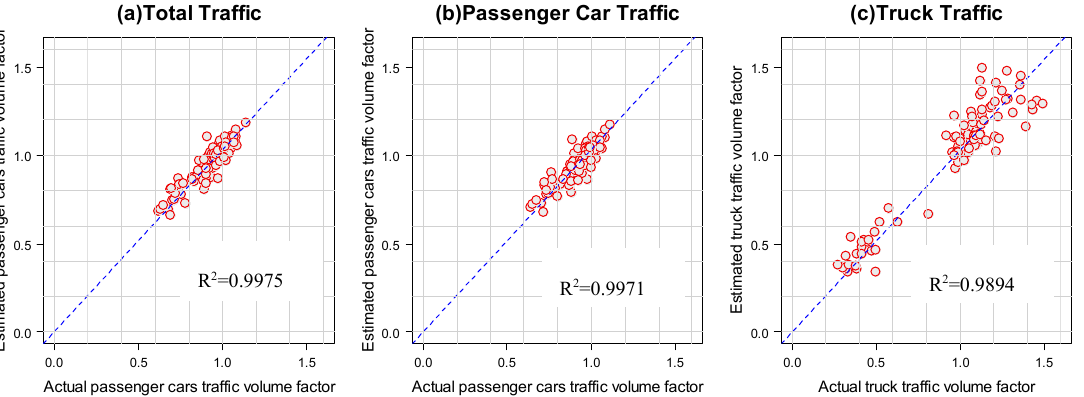
Figure 12. The accuracy of temporal transferability for dummy variable regression model at Leduc